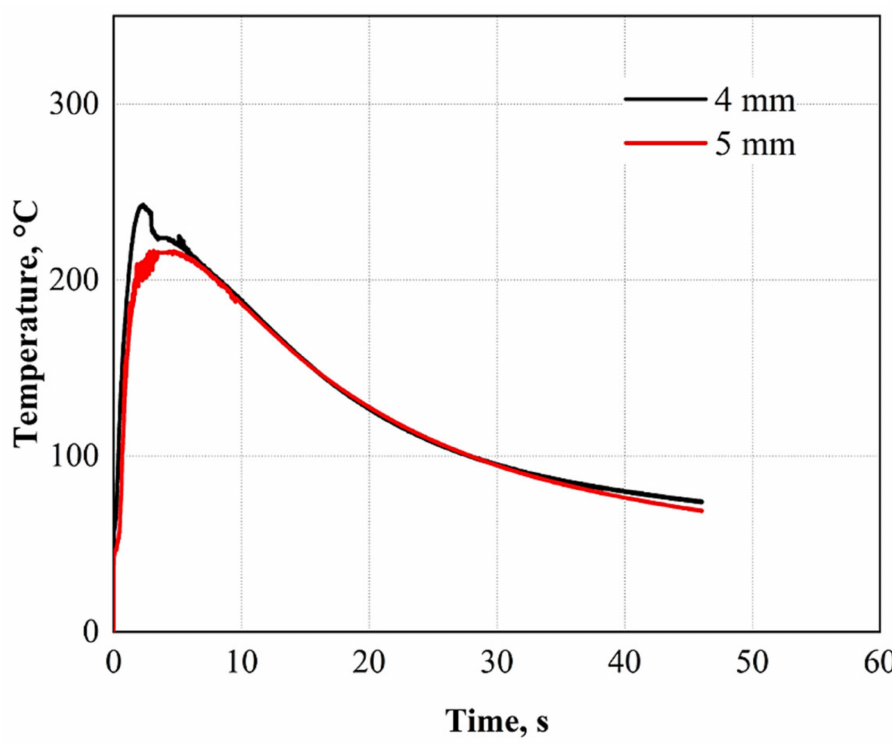
Figure 11. Experimental weld thermal cycles for DP